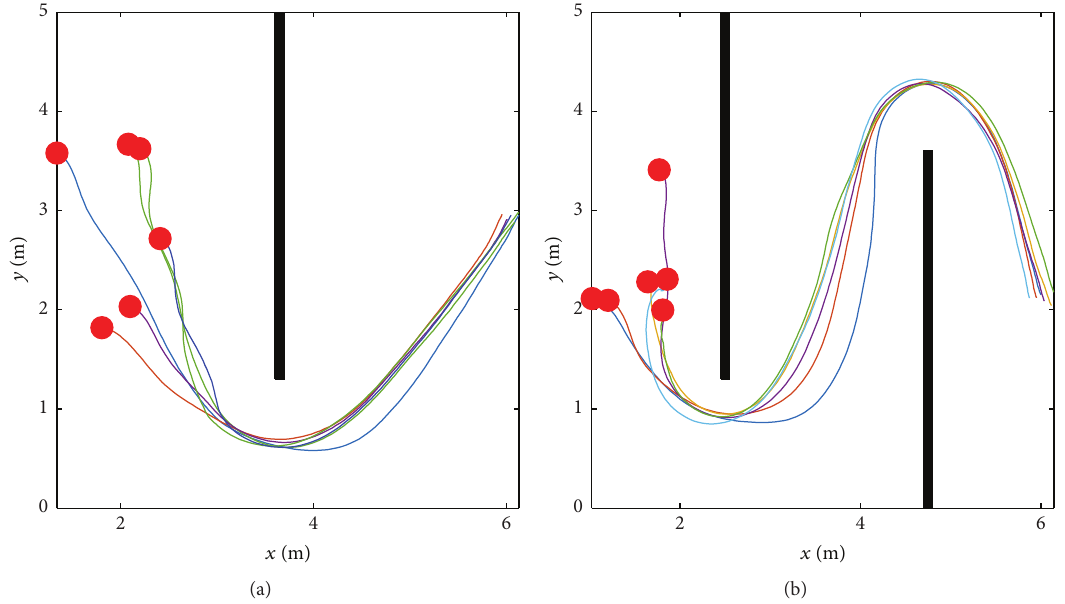
Figure 6: Demonstrated trajectories in two situations. (a) represents sampled data in task 1. (b) represents sampled data in task